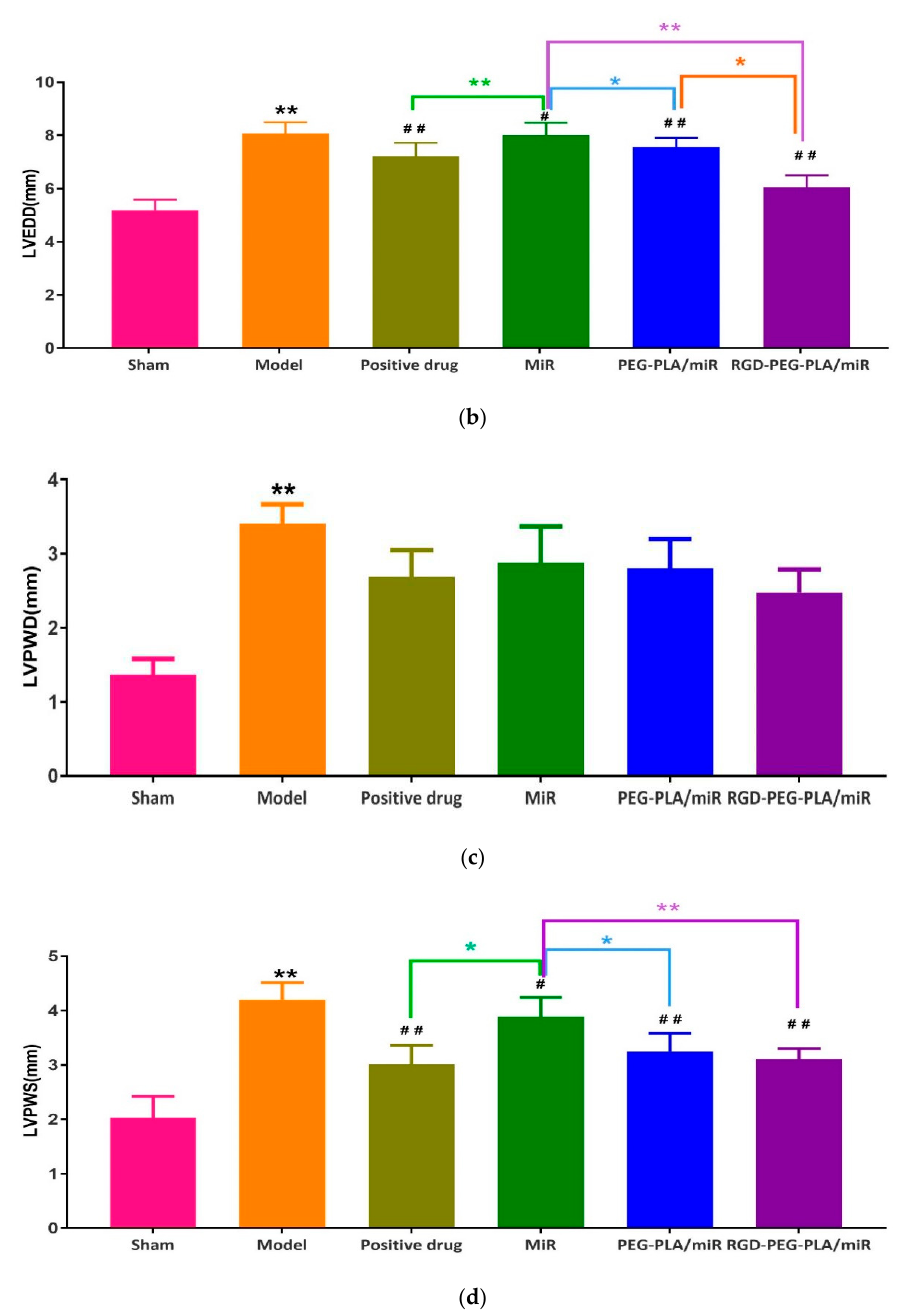
Figure 5. Results of ( a ) left ventricular end-systolic diameter (LVESD), ( b ) left ventricular end-diastolic diameter (LVEDD), ( c ) left ventricular posterior wall thickness at end-diastole (LVPWD), and ( d ) left ventricular posterior wall thickness at end-systole (LVPWS) on echocardiography in six groups of rats (mean ± SD, n = 6). Compared with the sham group, the difference was statistically significant (** p < 0.01). Compared with the model group, the difference was statistically significant ( # p < 0.05, ## p < 0.01). The color asterisks indicate significant differences between the two groups, * p < 0.05 and ** p < 0.01. Compared with those of the model group, the LVESD, LVEDD, and LVPWS of the